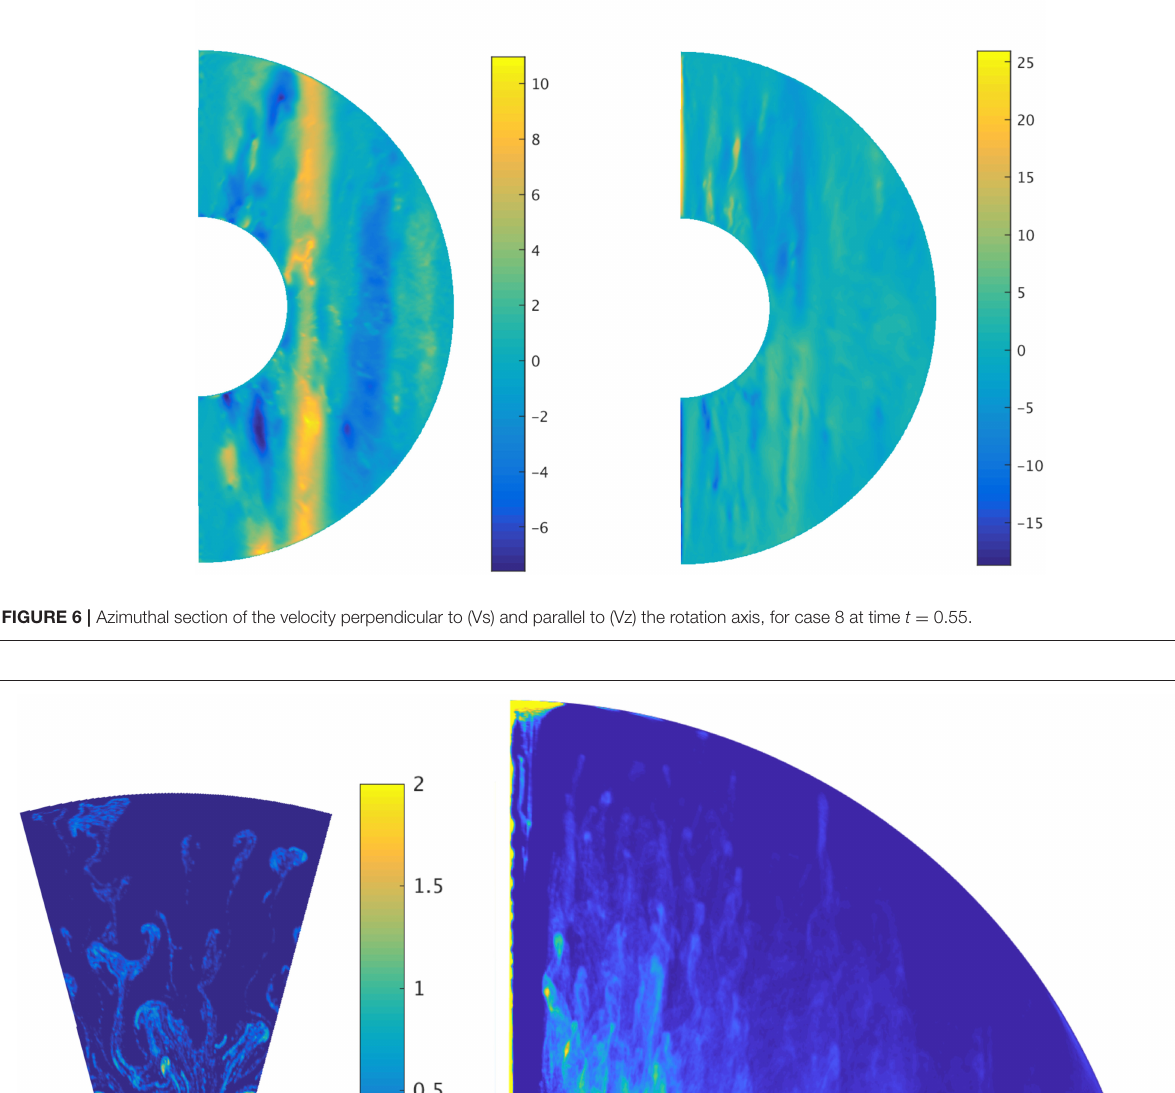
FIGURE 7 | (A) Equatorial section of the compositional field in case 10 at time t corresponding to the same snapshot. In both figures, color scales have been slightly saturated to improve the contrast of the compositional